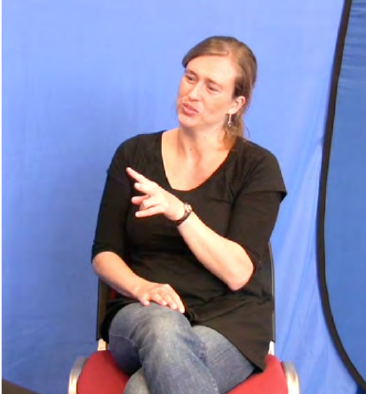
Figure 13. Indicating verb along the ‘body-diagonal’ axis used with constructed action